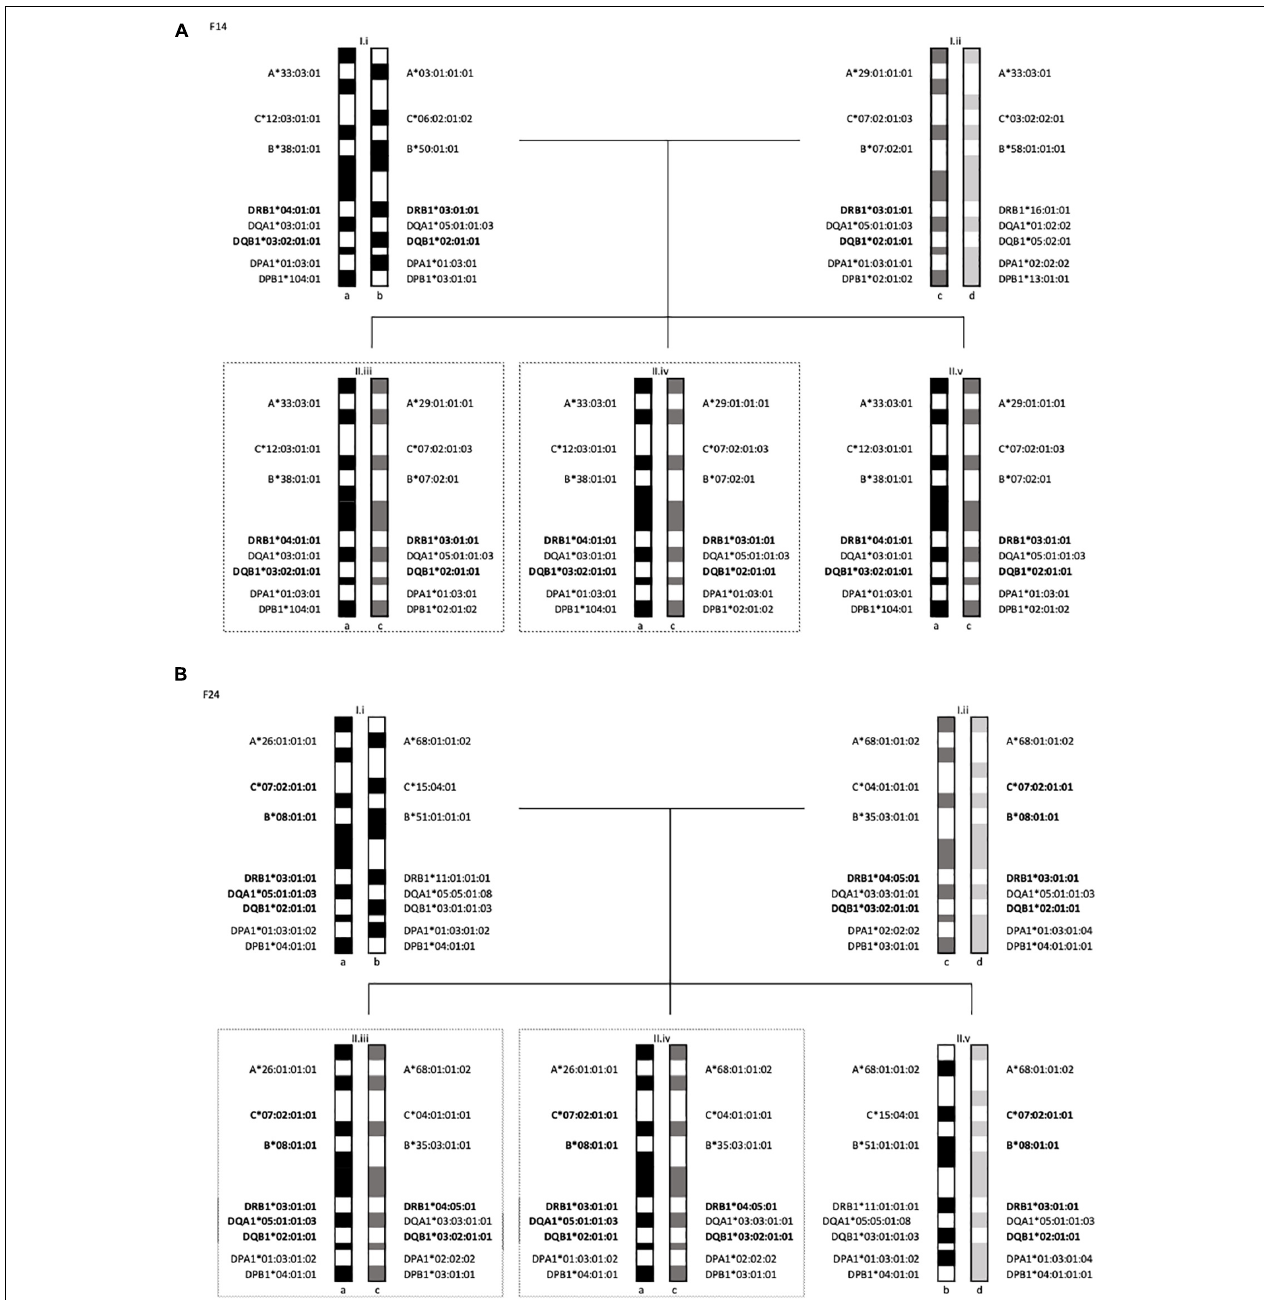
FIGURE 2 | Segregation analysis of the 5 families with multiple T1D subjects showing the MHC long-range haplotypes. In dotted lines are offsprings diagnosed with T1D. (A) Family 14 haplotypes II.iii and II.iv are diagnosed with T1D. (B) Family 24 haplotypes, II.iii and II.iv are diagnosed with T1D.